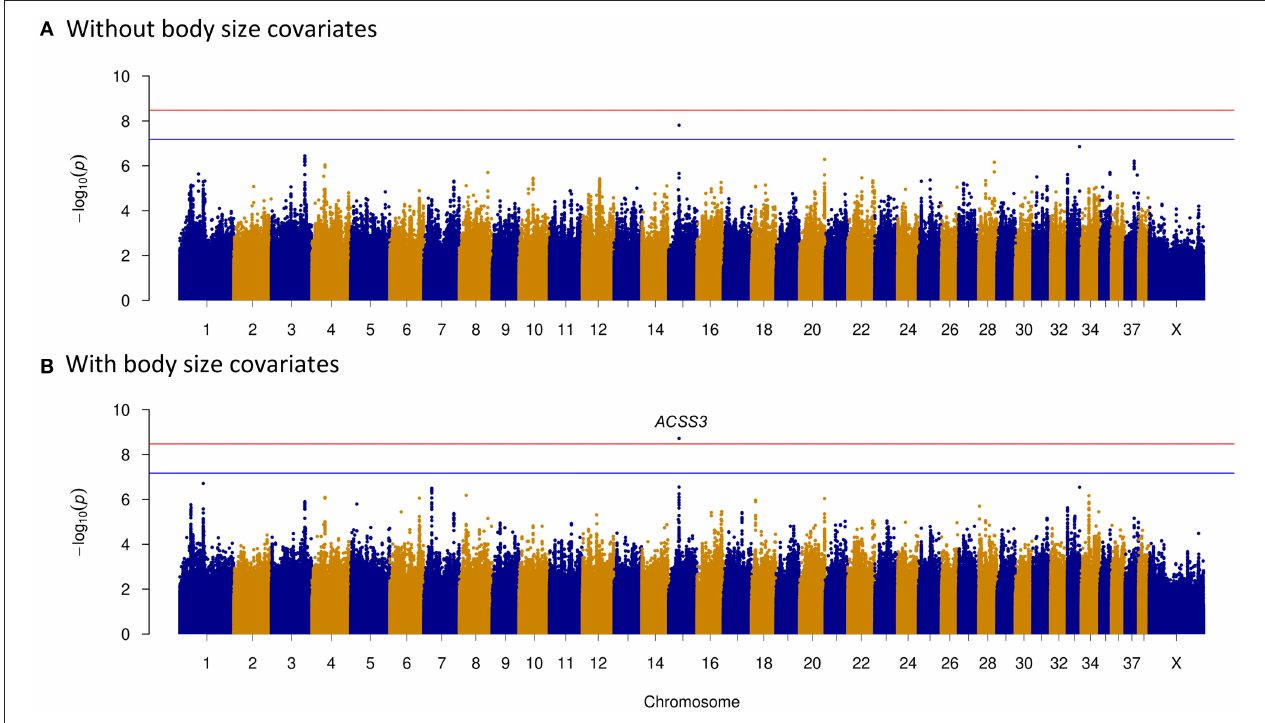
FIGURE 4 | Temperament genome-wide association study (GWAS) reveals an intron variant (CFA15:23,340,008 A > T) of ACSS3 gene. Manhattan plots showing the association of whole genome variants with temperament levels in dogs. Bonferroni and suggestive thresholds are indicated with red and blue lines. (A) Without including body size as a covariate. The ACSS3 intron variant is above the suggestive threshold. (B) Including body size as a covariate. The ACSS3 intron variant is above the Bonferroni